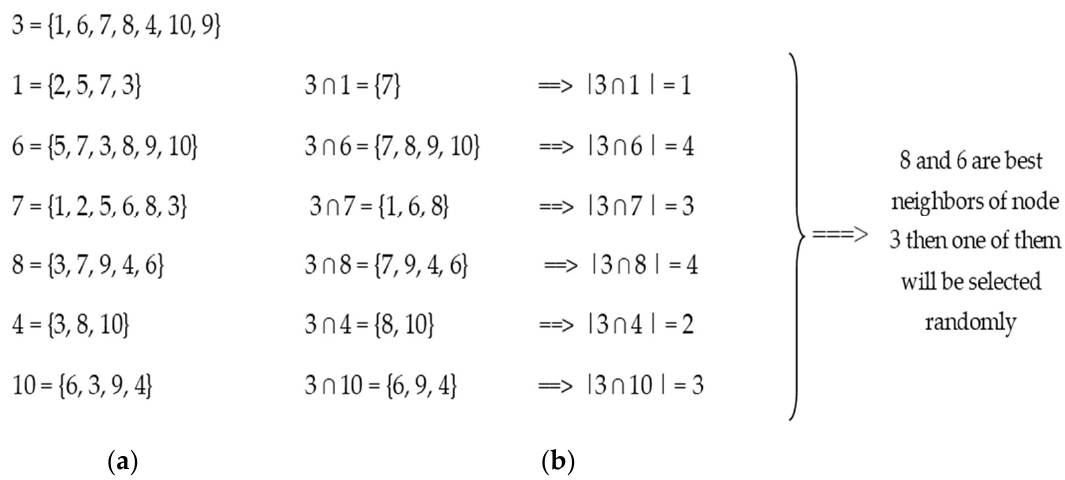
Algorithm 1: Algorithm of the Proposed